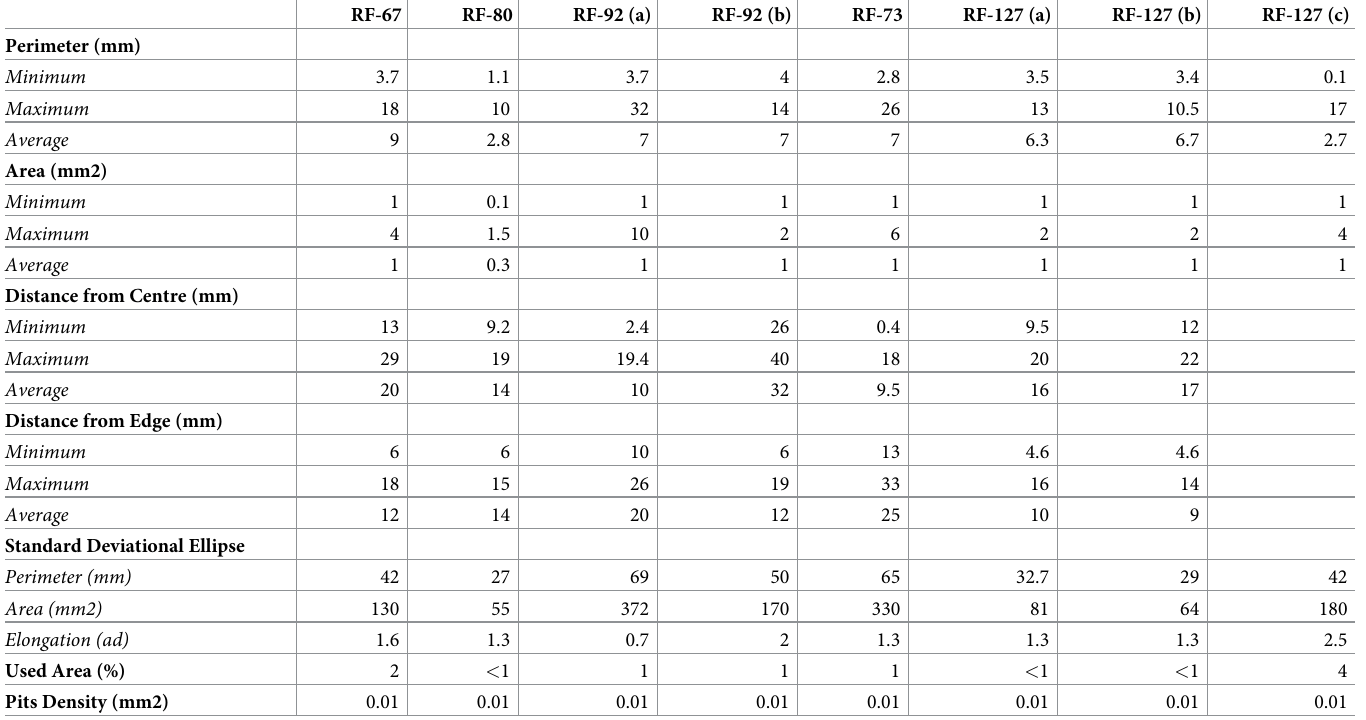
Table 5. Morphometric features of the wear identified on the utilised areas of the archaeological